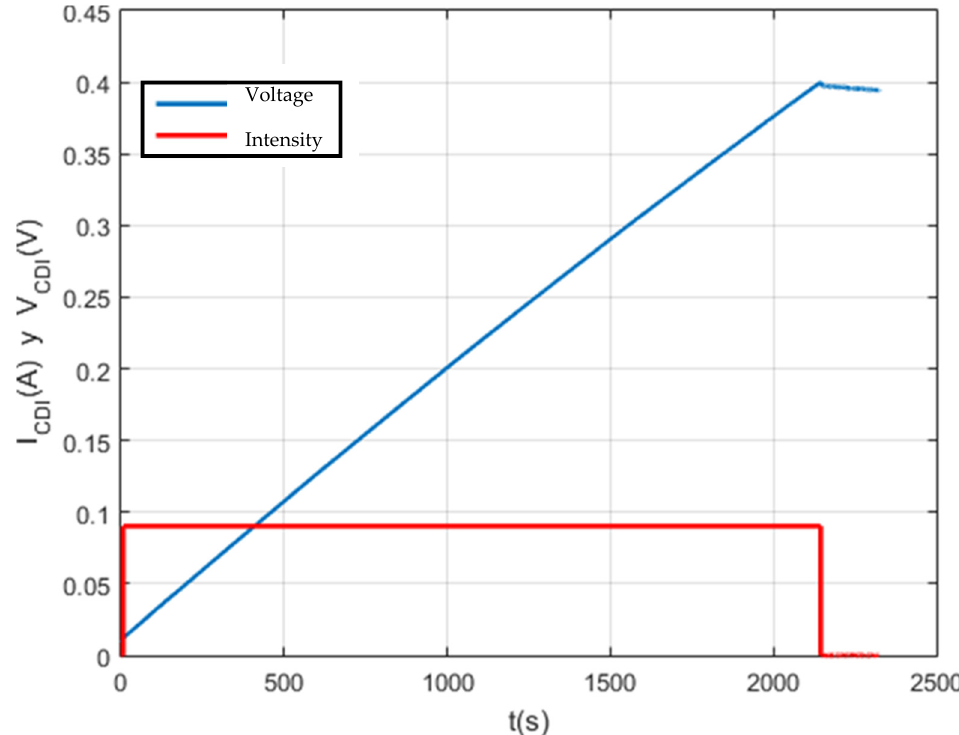
Figure 13. Test with a 650 F supercapacitor.